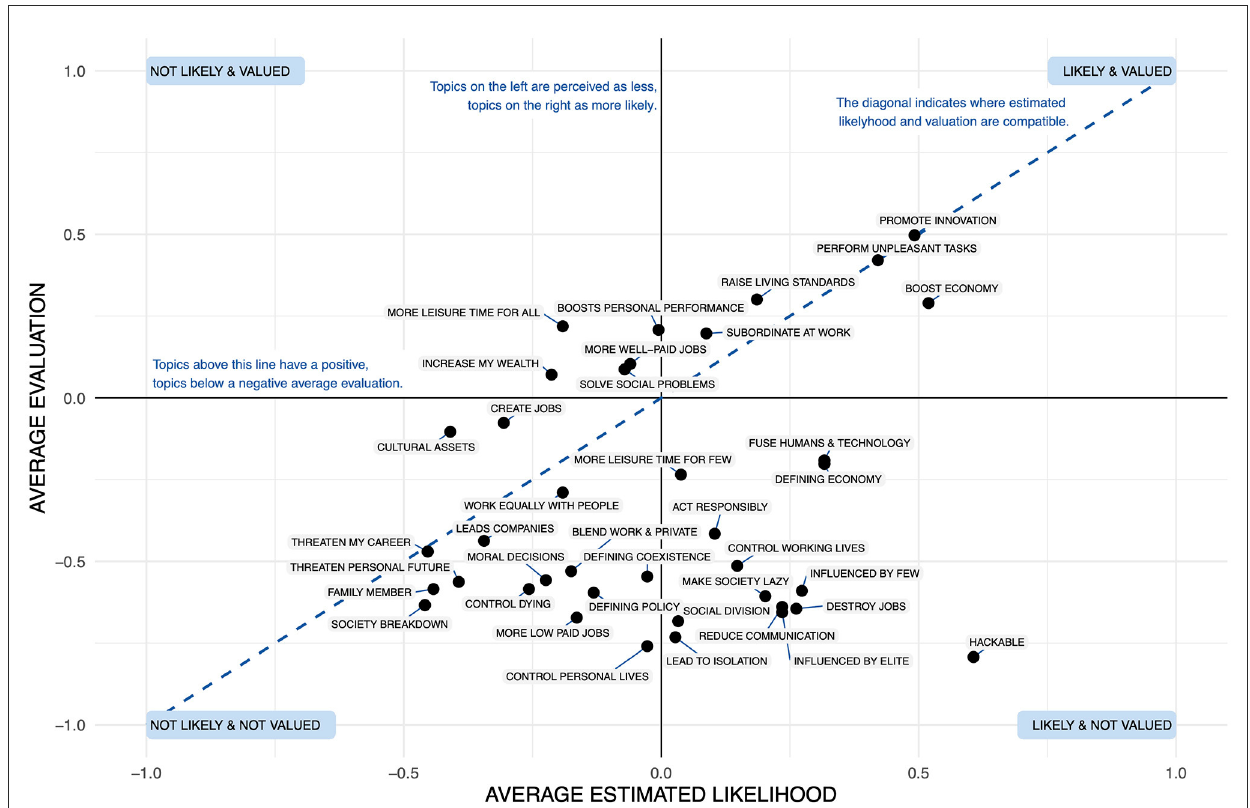
FIGURE2 Criticality map showing the relationship between estimated likelihood and evaluations for the AI predictions.